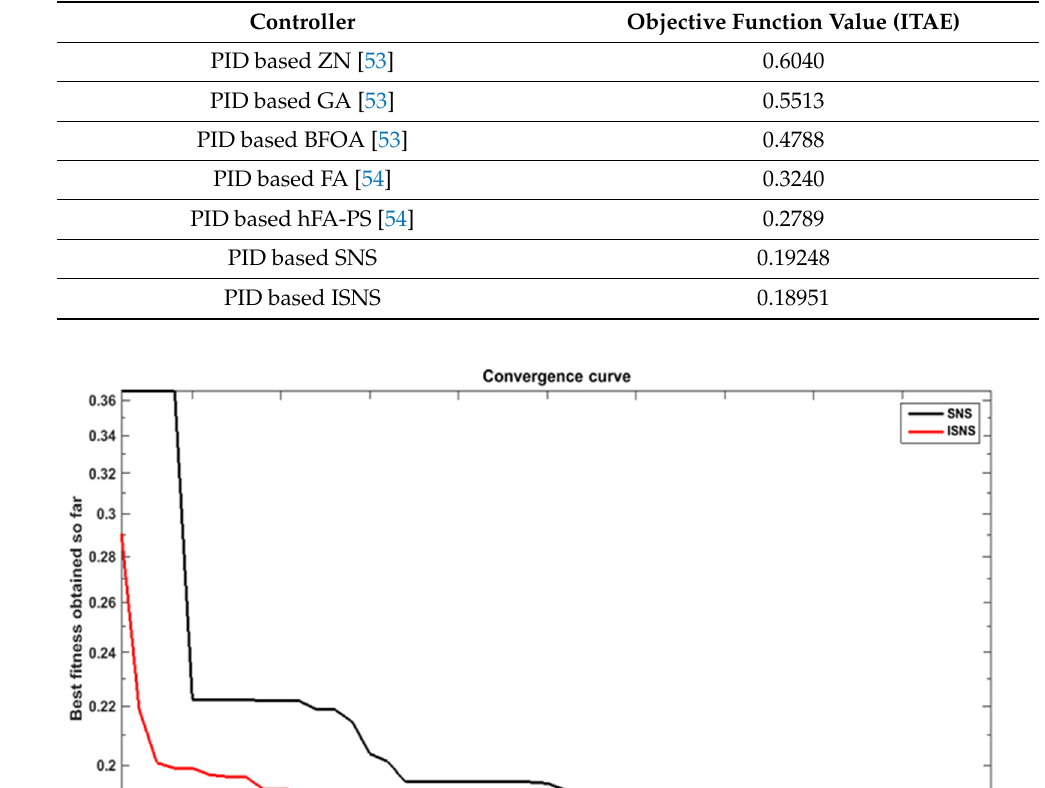
Figure 14. The system under consideration performance for scenario 1. 5.2. Scenario 2: Estimation of System Performance Considering Low and High Renewables Power Penetration The performance of the proposed PID controller based on ISNS algorithm has been checked by considering renewable power sources that linked to the considered two area power system in the presence of system nonlinearities and high load disturbance. Fur- thermore, Figure 15a displays the resulted output power from the PV power station and wind farm in case of low renewables penetration, while Figure 15b displays the resultant output power from the PV power station and wind farm in case of high renewables pen- etration. Moreover, Table 4 lists the optimal parameters of the proposed PID controller- based ISNS algorithm. Furthermore, the operating conditions of this scenario have been listed in Table 5. The system response considering renewable power penetration (i.e., 7%